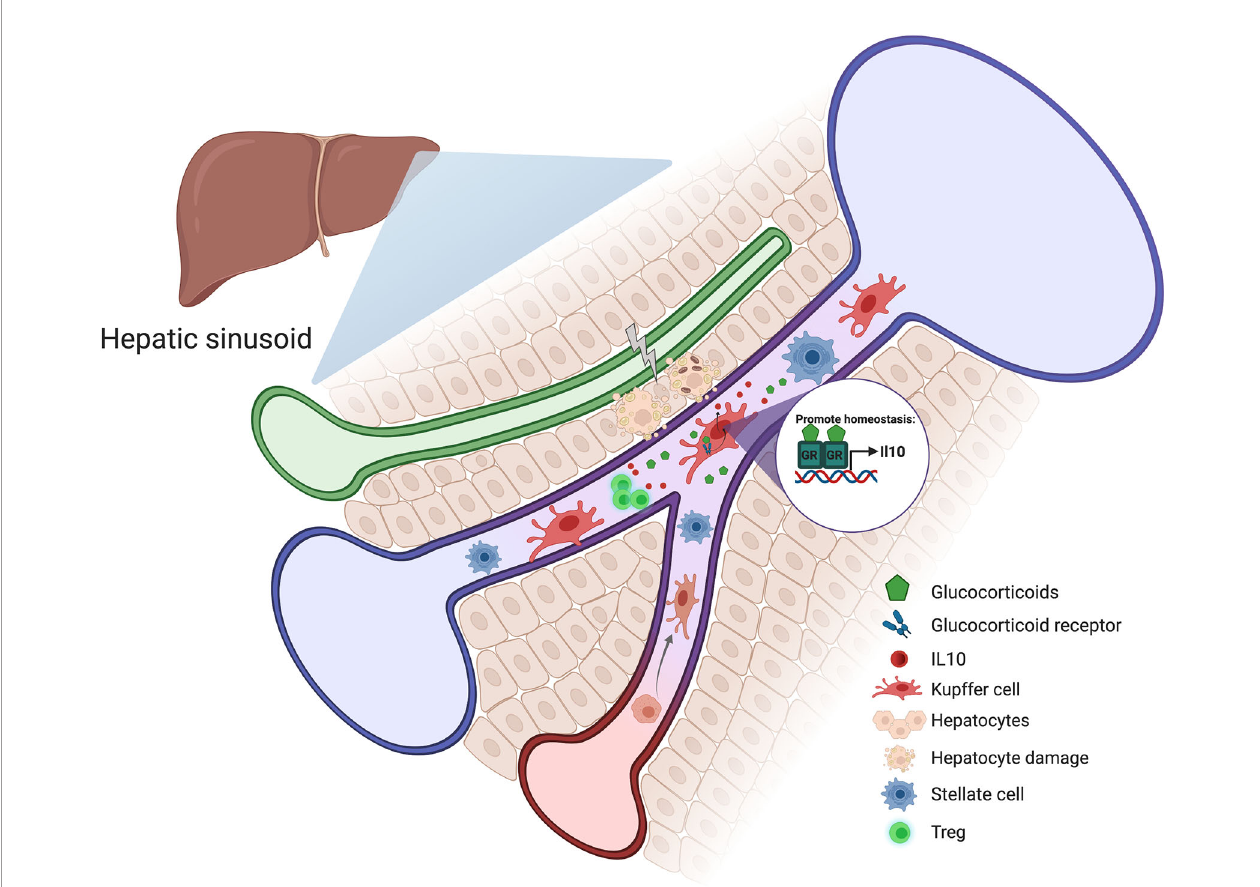
FIGURE 4 | Schematic representation of how glucocorticoids could contribute to liver homeostasis. Stress and hepatocyte injury around the hepatic sinusoid cause an increase in glucocorticoid levels which induces Kupffer cell activation and IL-10 production. Kupffer cell-derived IL-10 exerts hepatoprotective and tolerogenic effects through Treg